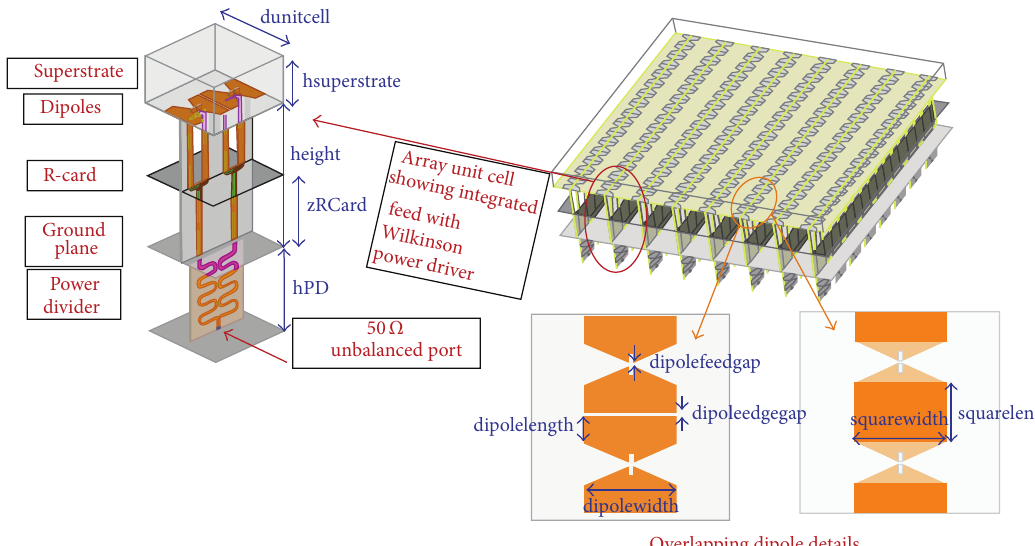
Figure 5: Illustration of the tightly coupled dipole array (TCDA) integrated with a balun to create the TCDA-IB array. Enhanced coupling between dipole is achieved using overlapping dipoles at the array’s surface. The Marchand-type balun is depicted to the left and a single feed is used to feed a pair of dipoles (creating the unit cell) to double the impedance from the Wilkinson divider for improved matching at the dipole terminals.